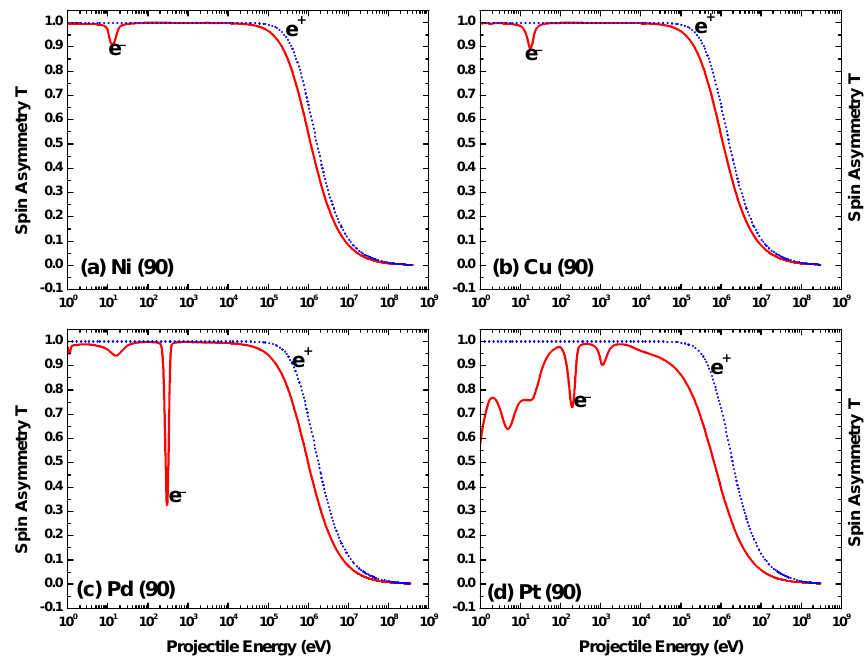
Figure 27. Energy variation of the spin asymmetry parameter T for both electron and positron impact scattering from ( a ) Ni 58 , ( b ) Cu 63 , ( c ) Pd 108 , and ( d ) Pt 196 at scattering angle θ = 90 ◦ . The angular dependence of U and T for a collision energy of 100 eV is displayed in Figures 28 and 29. For positron impacts, U ≈ 0 and T ≈ 1 irrespective of angle and target, while it can be seen that for electron impacts the deviation of T from this limiting value is considerably smaller than that of U (except for the heaviest atom), confirming the